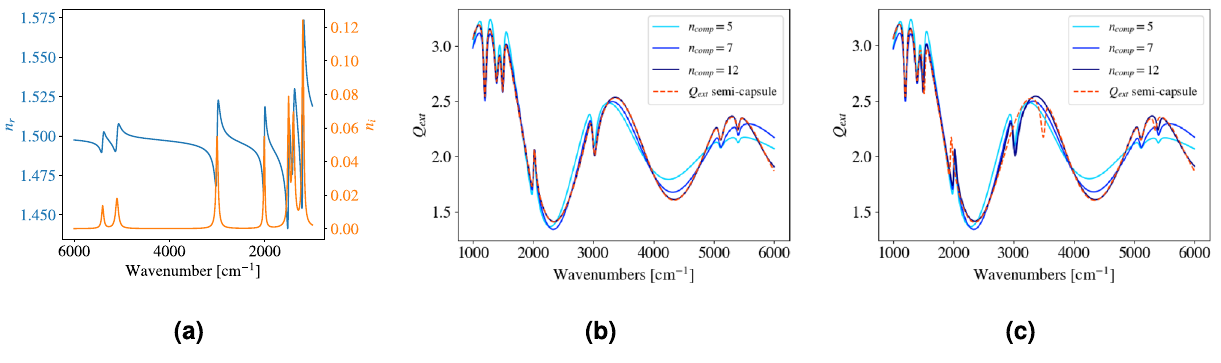
Figure 5. ( a ) The refractive index used in the calculations of Q ext , where the real part n r is shown in blue and semi − capsule the imaginary part n is shown in orange. ( b ) Q ext (red dashed line) is reconstructed from a number n comp basis vectors. The blue lines show different reconstructed Q semi − capsule,r ext , with a different number of basis vectors used. ( c ) When the chemistry (determined through the refractive index) used for calculating the 100 Q sphere ext curves is changed, the reconstruction Q semi − capsule,r ext fails at the absorption sphere 100 extinction efficiencies Q ext